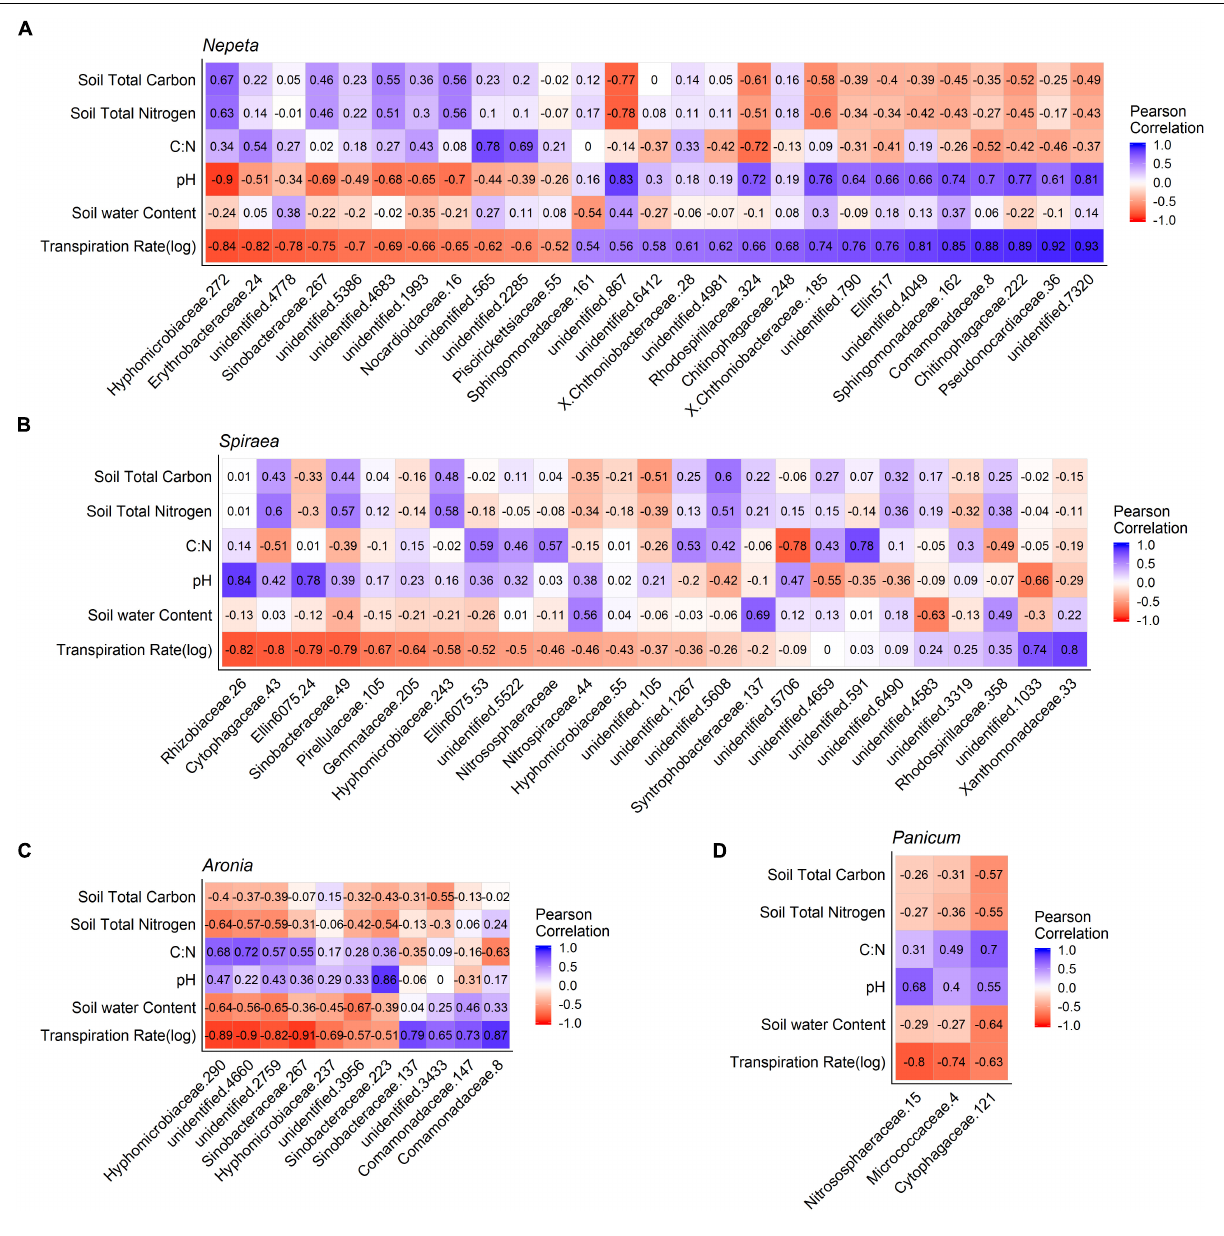
FIGURE 5 | Pearson correlation matrix of bacteria OTUs that were significantly correlated with the plant transpiration for Nepeta (A) , Spiraea (B) , Aronia (C) , and Panicum (D) . Eupatorium was not included due to low sample